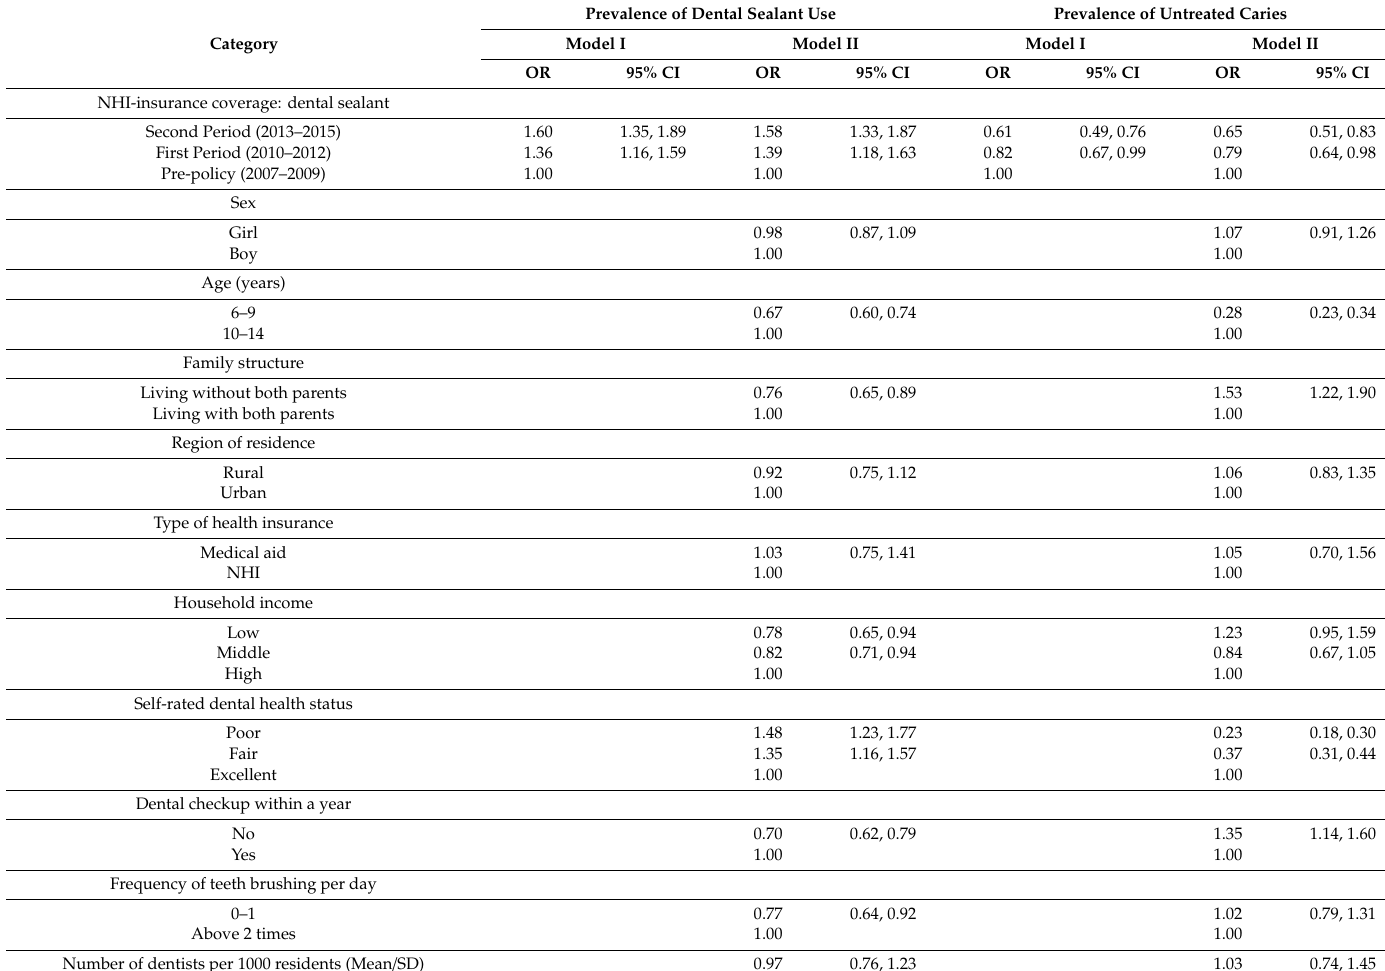
Table 3. Association between dental insurance coverage and using dental sealant and having untreated caries. Prevalence of Dental Sealant Use Prevalence of Untreated Caries Category Model